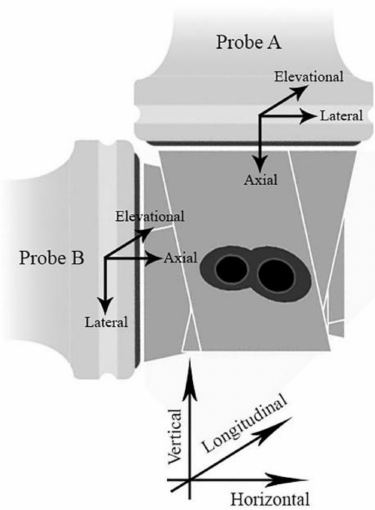
Figure 5. The axis definition and nomenclature for the probe related directions: axial, lateral, and elevational. Vertical, horizontal, and longitudinal directions are related to the phantom